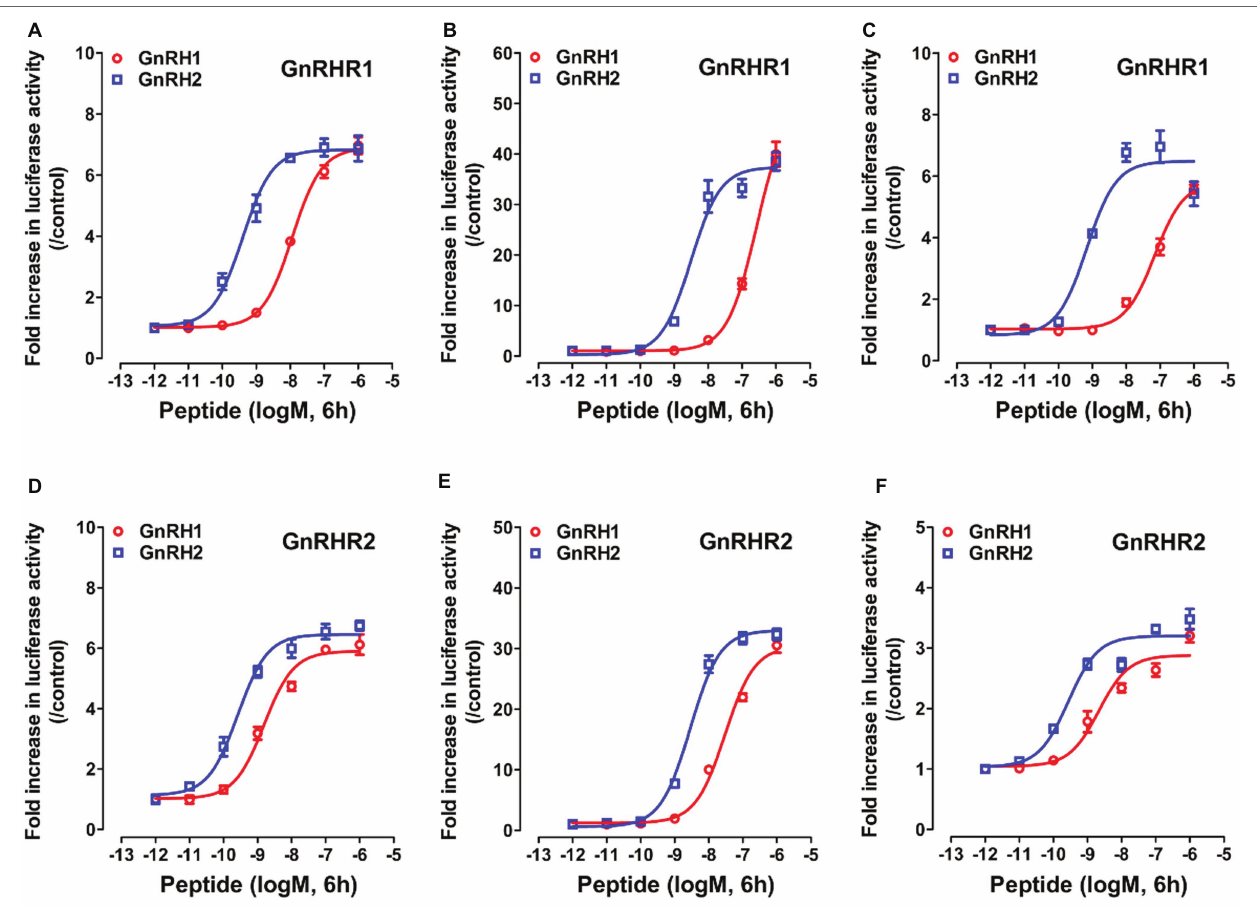
FIGURE 5 | Activation of chicken GnRHR1 or GnRHR2 expressed in CHO cells by chicken GnRH1 or GnRH2, monitored by pGL3-NFAT-RE-luciferase (A,D) , pGL4-SRE-luciferase (B,E) , and pGL3-CRE-luciferease (C,F) reporter systems. CHO cells co-transfected with empty pcDNA3.1(+) vector and pGL3-NFAT-RE-